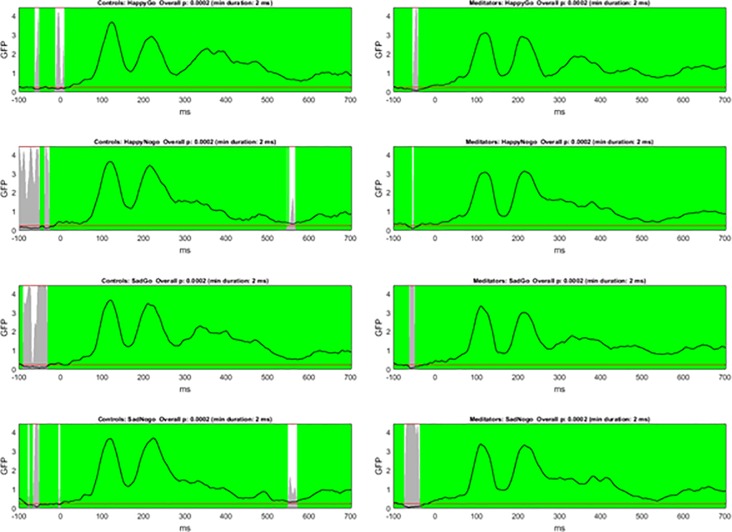
Topographical consistency test.The line indicates GFP values and the grey bars indicate p-values, with the red line indicating p = 0.05. White sections indicate regions without significantly consistent distribution of activity within the group/condition, while green periods indicate consistent distribution of activity across the group/condition after duration control for multiple comparisons across time [42]. Note significant consistency across all conditions for both groups except for prior to stimulus onset, and around 550 ms in the Nogo trials for control participants.